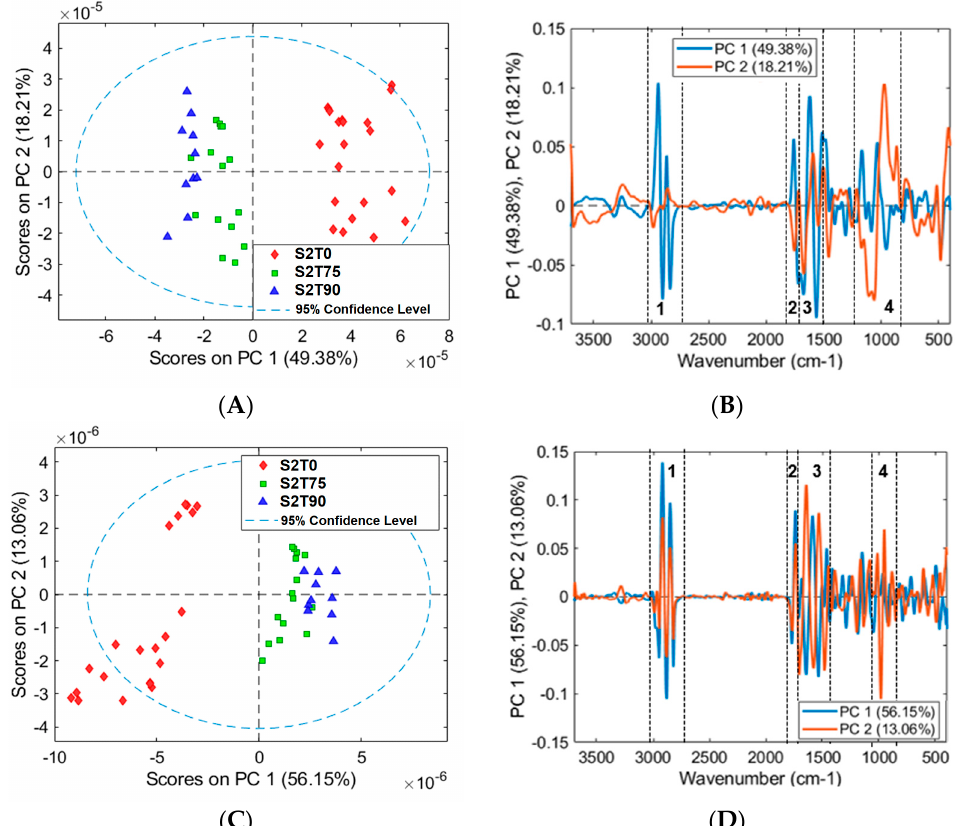
Figure 5. Score ( A ) and loading ( B ) plots from fi rst derivative spectra and score ( C ) and loading ( D ) plots from second derivative spectra of S2 samples, respectively. The numbers indicated in ( B ) and ( D ) correspond to the following spectral ranges: (1) 2920–2820 cm − 1 (C-H stretching); (2) 1740–1700 cm − 1 (COOH stretching/carbonyl (C=O) stretching); (3) 1620–1550 cm − 1 (N-H stretching and C=O stretching of amide I)/carbonyl (C=O) stretching, C-C aromatic stretching, NH2 group bending/C-C aromatic ring stretching phenolic compounds, N-H bending and C-N stretching of protein; (4) 1150–